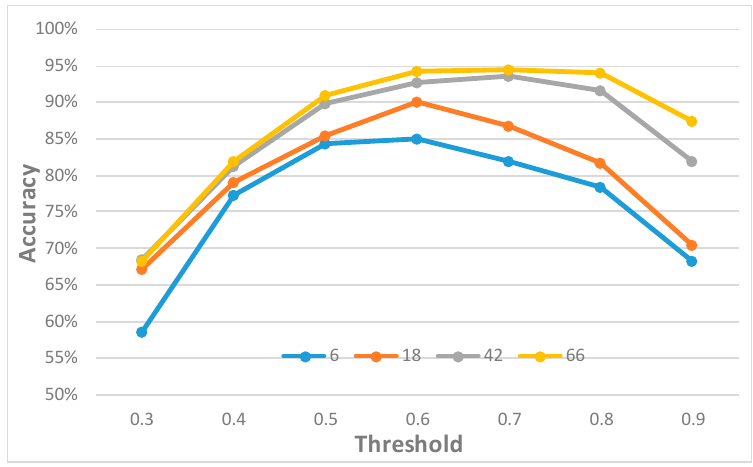
Figure 6. The influence of number of depth images on the identification accuracy.